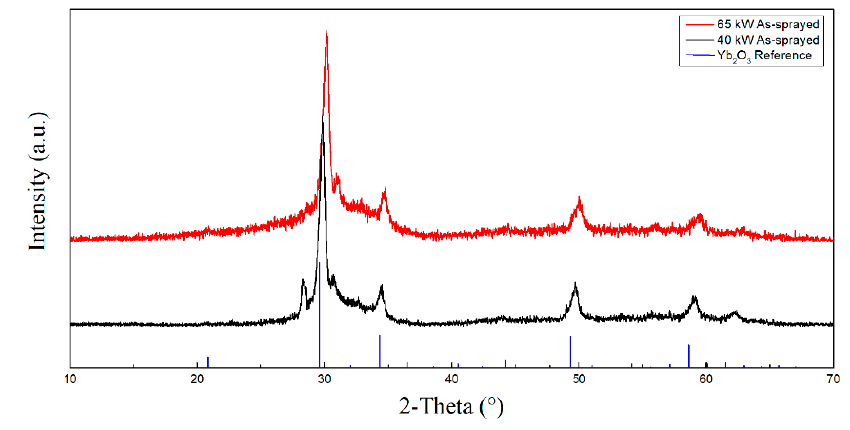
Figure 2. XRD patterns of as-sprayed ytterbium silicate top-coats.